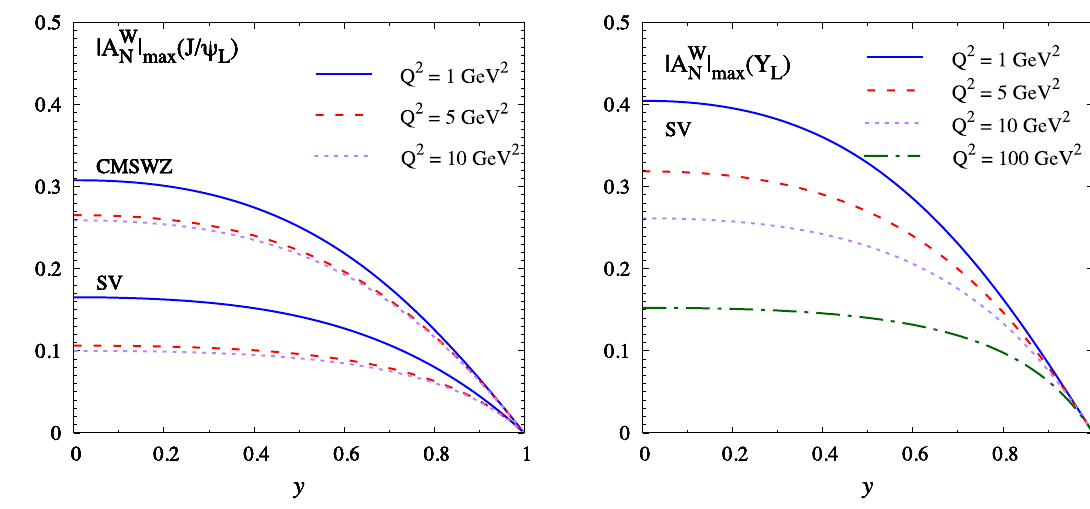
Fig. 4 Upper bounds for the (cid:2) cos2 φ T (cid:3) and A W labels SV and CMSWZ denote the adopted LDME sets, given in Tables asymmetries, with N W = sin (φ S + φ T ), sin (φ S − 3 φ T ) , for e p → e (cid:5) J /ψ X (left panel) 1 and 2. The bounds obtained with the BCKL set, not shown explicitly, lie always between the SV and CMSWZ results presented in the left and e p → e (cid:5) ϒ X (right panel), with the J /ψ and ϒ mesons longitudi- nallypolarizedalongtheirdirectionofmotioninthe γ ∗ p center-of-mass frame, as a function of y and for different values of the scale Q 2 . The